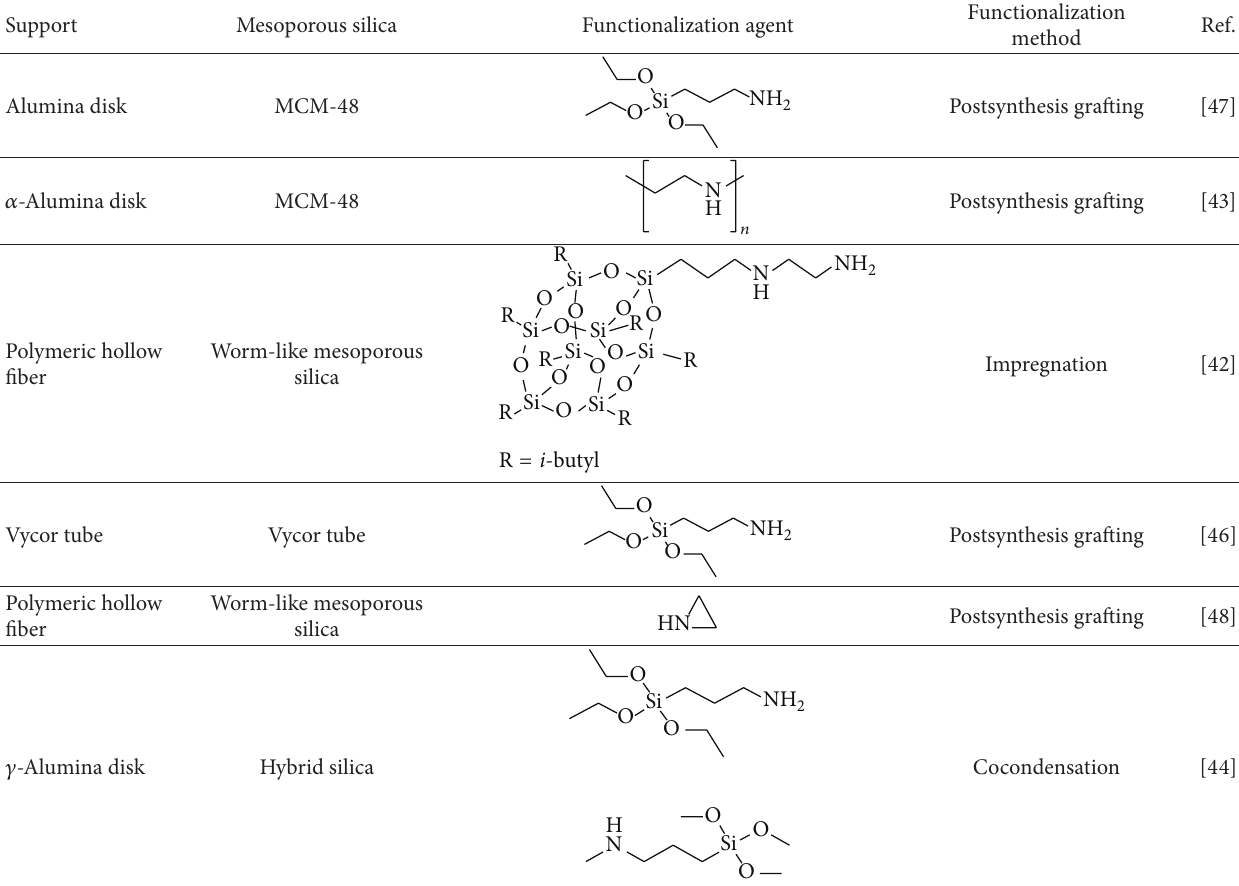
Table 1: Published mesoporous silica membranes functionalized with amine groups for CO 2